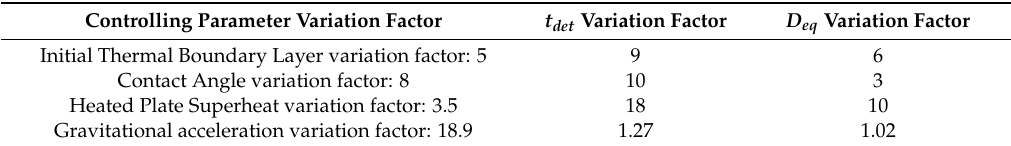
Table 8. Comparison of relative importance of the effect of the examined controlling parameters in the bubble detachment characteristics (R113). Resulting change factors in the bubble detachment characteristics with respect to the maximum variation factors in the examined controlling